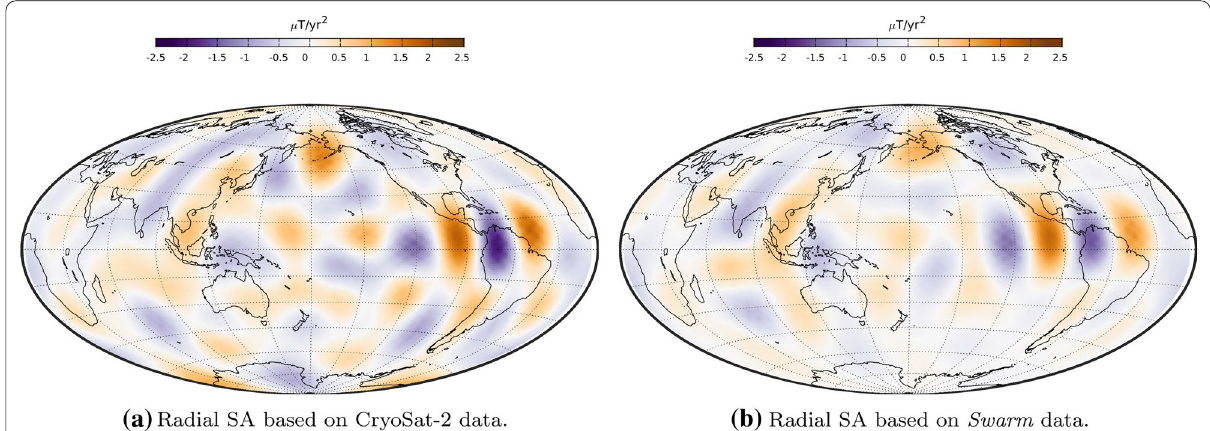
Fig. 8 Maps of radial SA at the CMB centered on 2017.0 derived from differences of SOLA SV estimates in 2016.0 and 2018.0 using data